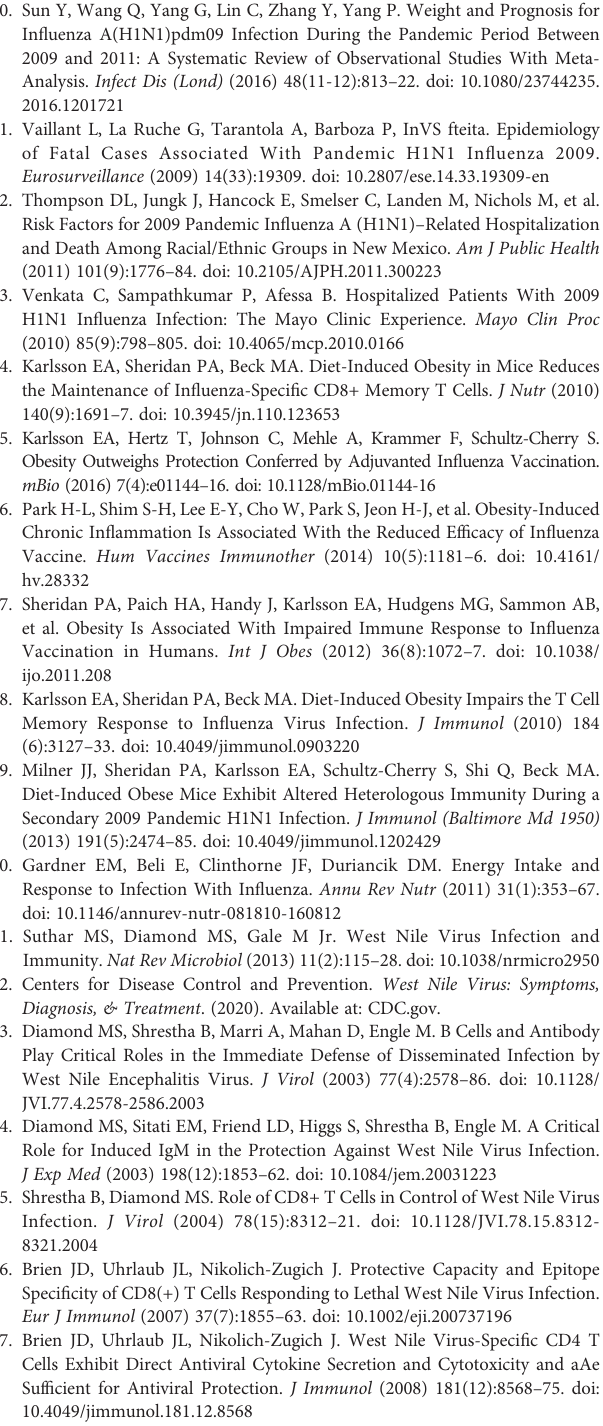
Supplementary Figure 4 | Obese males have no defects in neutralizing antibody function against WNV. At 8 (wt n=3 and obn=4), 15 (wt n=4 and ob n=3) and 30 (wt n=11 and ob n=13) DPI, focus reduction neutralization tests were performed to